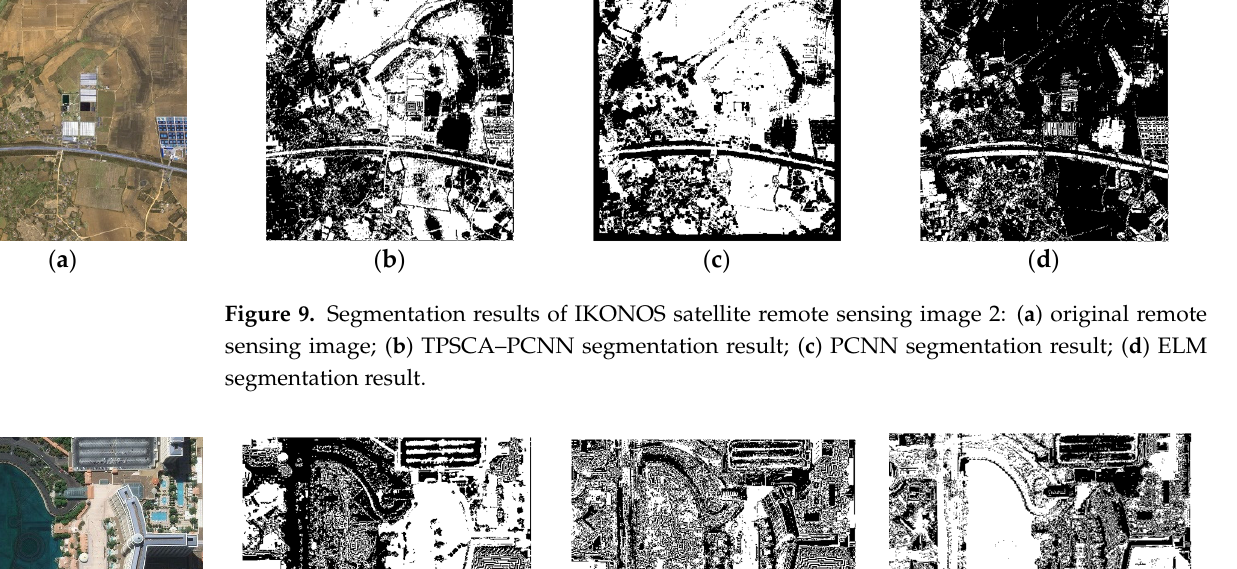
Figure 8. Segmentation results of IKONOS satellite remote sensing image 1: ( a ) original remote sens- ing image; ( b ) TPSCA–PCNN segmentation result; ( c ) PCNN segmentation result; ( d ) ELM segmen- tation result.